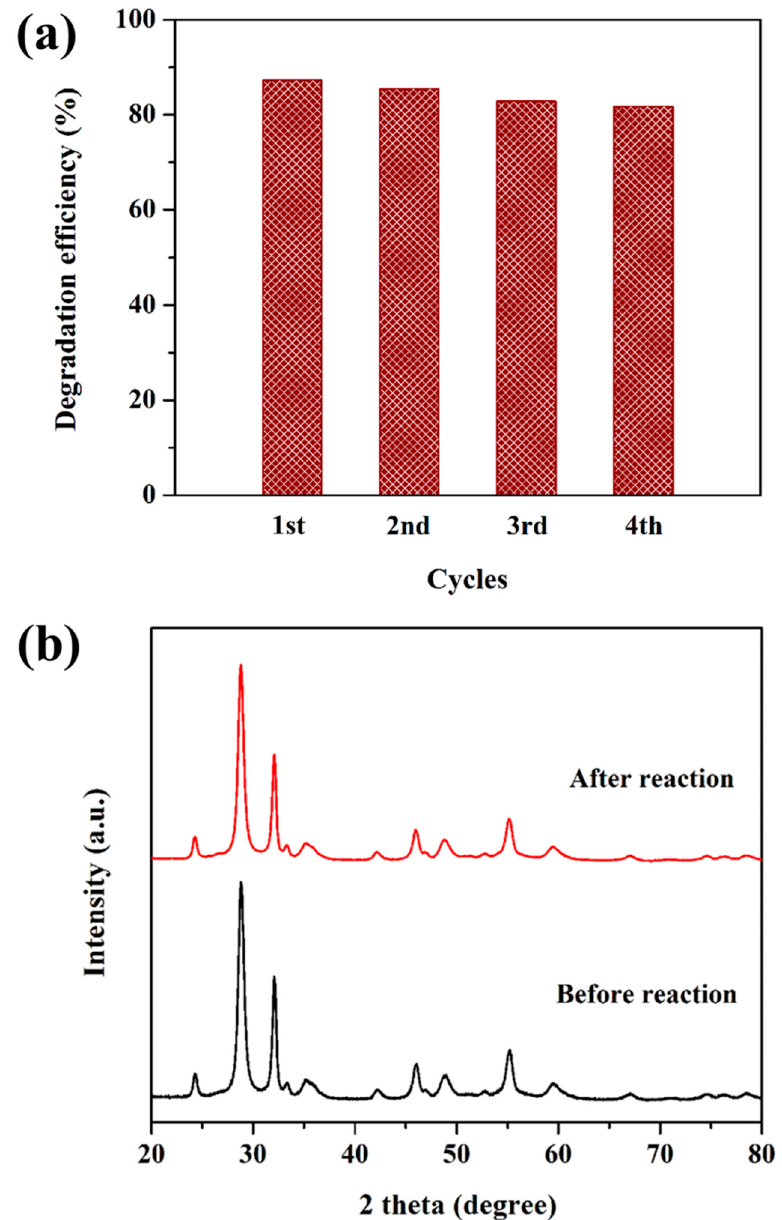
Figure 9. ( a ) Photocatalytic degradation of CIP for four successive runs; ( b ) XRD patterns of IBOCH-2 before and after the recycling test.